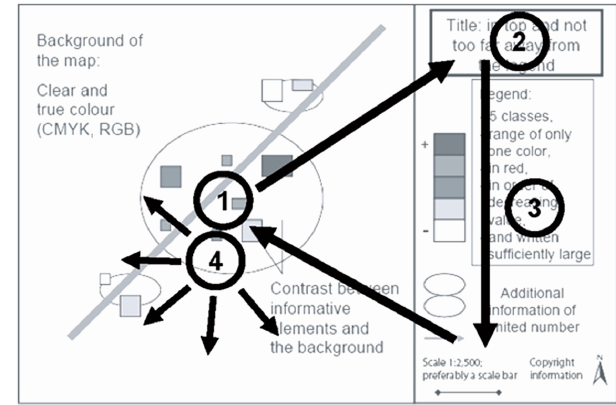
Figure 1. Schematic representation of the visual strategy introduced by Fuchs et al.